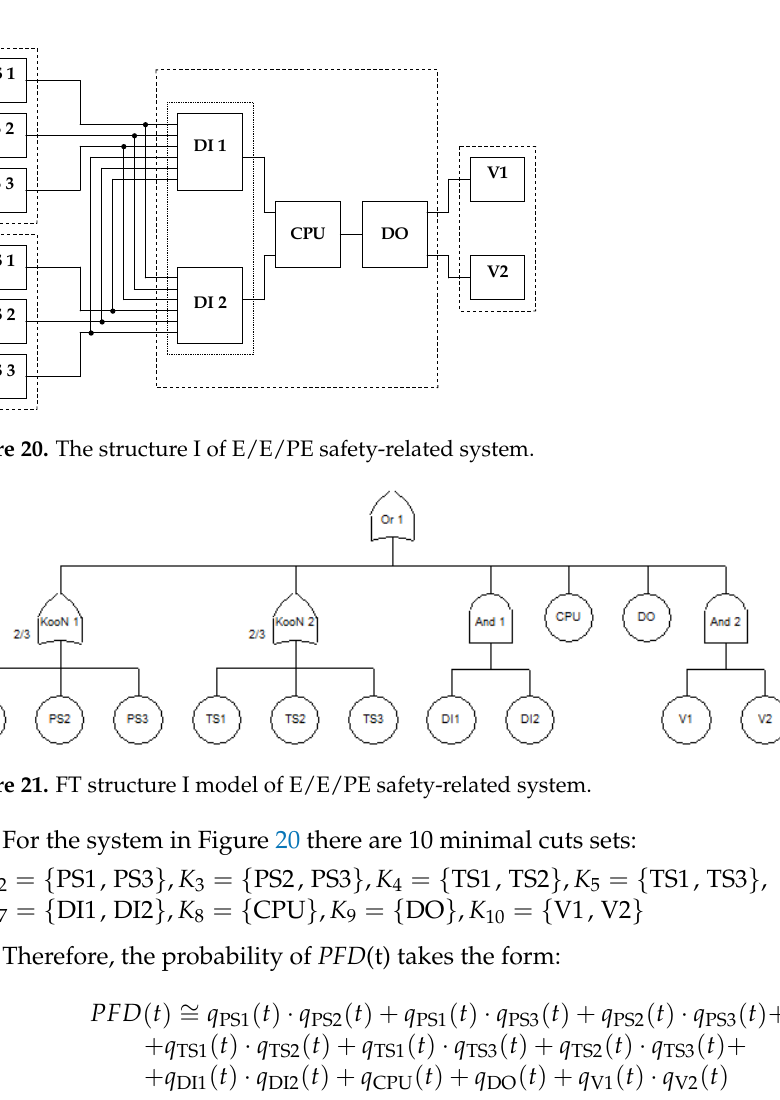
PFD avg 10 -3 Figure 19. Verification of safety integrity level for a point value of PFD avg . In this figure, if we consider, for instance, SIL2, µ SIL2l ( PFD avg ) as the possible level to fulfil SIL2 lower limit probabilistic criterion; µ SIL2u ( PFD avg )—the possibility level) to fulfil SIL2 upper limit probabilistic criterion. When µ SILl ( PFD avg ) and µ SILu ( PFD avg ) are equal to 0.5 the SIL level is indicated unconditionally. When the µ SIL2l ( PFD avg ) and µ SIL2u ( PFD avg ) are close to 0 or 1 (lower/upper limits of the probability interval), the SIL is determined con- servatively (lower level of SIL assumed) or additional analysis is undertaken concerning assumptions and sensitivity analyses of the probabilistic model. PFD avg in formula (12) for a subsystem of the given architecture is calculated e.g., according to formula (18). If the value of probability PFD avgSYS is lower than a relevant probabilistic criterion value for given SIL (Table 1), then the designed safety-related sys-